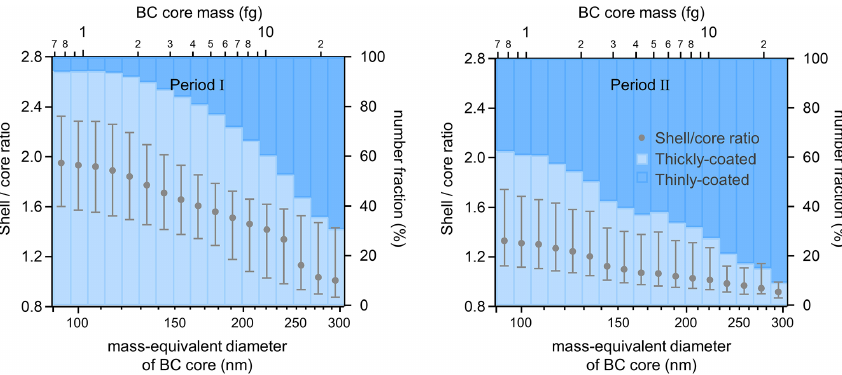
Figure 5. Variations in the number fraction of thickly coated BC and the shell / core ratio among the particles containing varying BC mass during Period I and Period II.